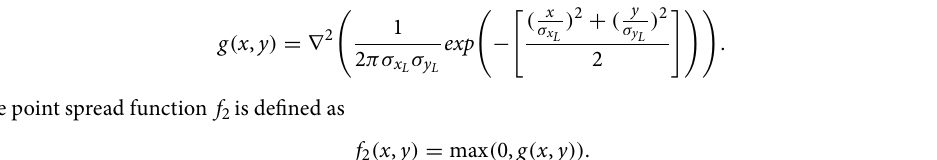
peak intensity value to be 255 and is denoted I 3 (Process A-2 in Fig. 5). Constant C 1 can be changed to control the intensity value of cell head. The image I 3 is complemented to produce the image of dark-oval-like center on a white background (Process A-3). In Process A-4, the background for the simulation image is added. Let B L be the background that will be added to the simulated image. The size of B L is N by N . In the examples in this section, a uniform background is assumed, where every value in the pixel is equal to 204 ( B L ( x , y ) = 204 , 80% of 255). The value 255 − B L is subtracted from the image I 4 and any value below 0 is set to 0. The resulting image is denoted image I 5 ( I 5 = max [ 0, I 4 − ( 255 − B L ) ] ). Process B: sperm head (membrane) generation (Part 2). The flowchart of Process B is shown in Fig. 7. In typical semen image samples, one can observe a halo-like membrane surrounding the sperm head, as shown on the left of Fig. 1 (referred to as “a horseshoe-shaped halo” in Urbano et al. 3 ). To generate this halo-like membrane around the cell, a modified version of Laplacian of the 2-D normal distribution filter is used as the second point spread function on image I 1 . The Laplacian of the 2-D normal distribution filter is defined as